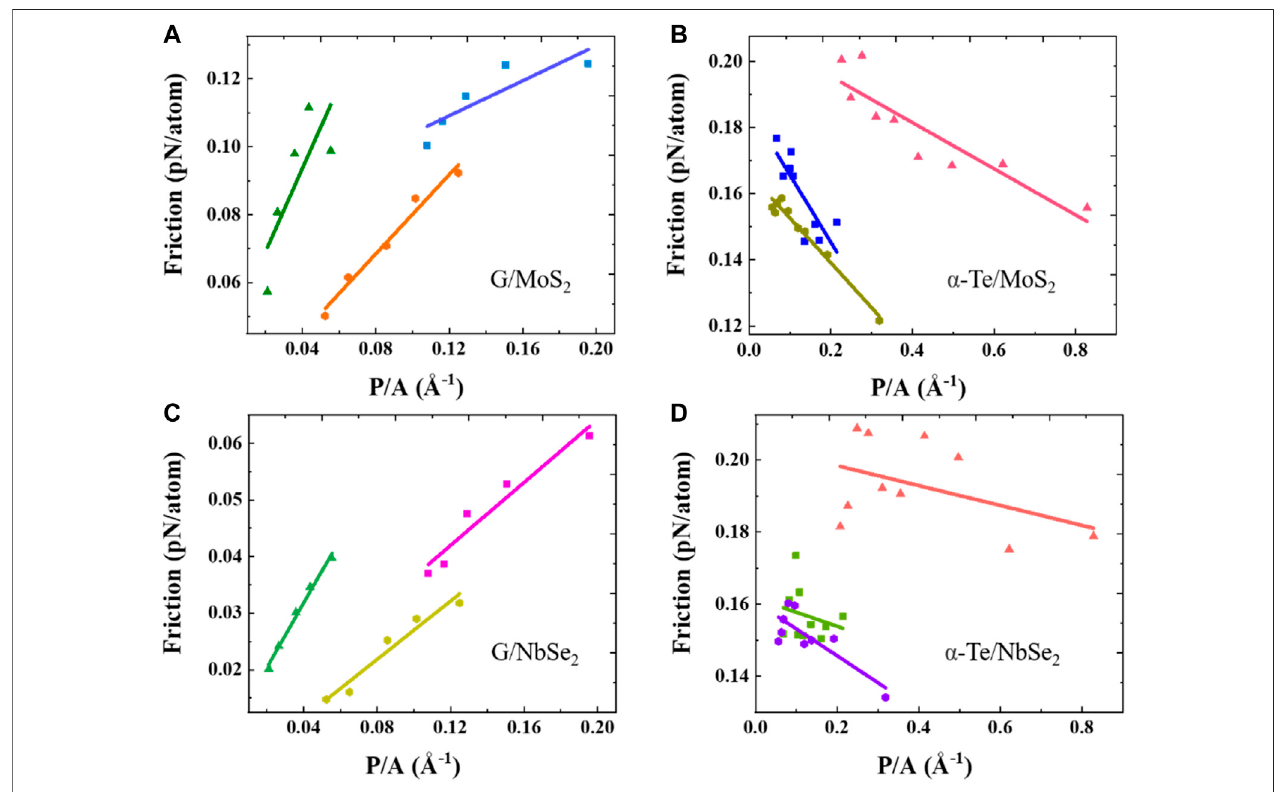
FIGURE8| Variationinfrictionalforcewithsizefordifferentshapedsliders. (A) Graphene/MoS 2 ; (B) α -Te/MoS 2 ; (C) Graphene/NbSe 2 ; (D) α -Te/NbSe 2 .Theshape ofthedatapointsrepresentstheshapeofthesliderintheMDsimulation,whicharerectangular,triangularandhexagonal.Thesolidlineisobtainedbyleastsquares fi tting based on the data